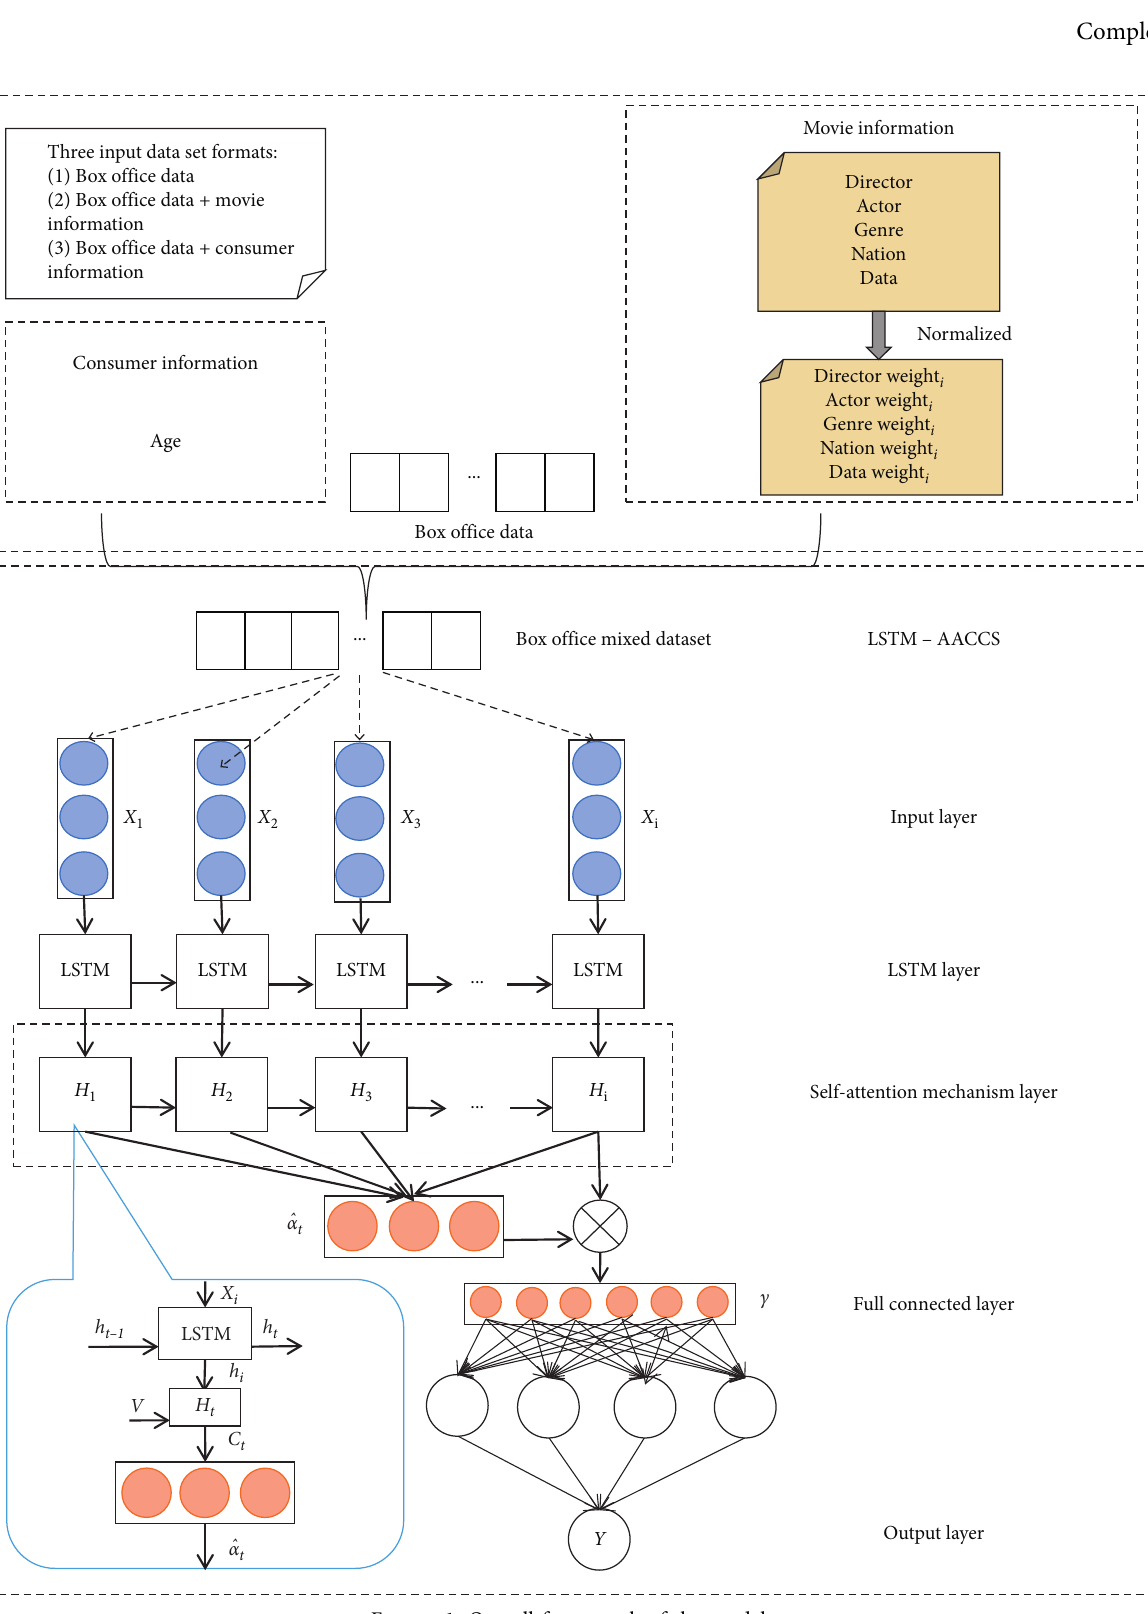
Figure 1: Overall framework of the